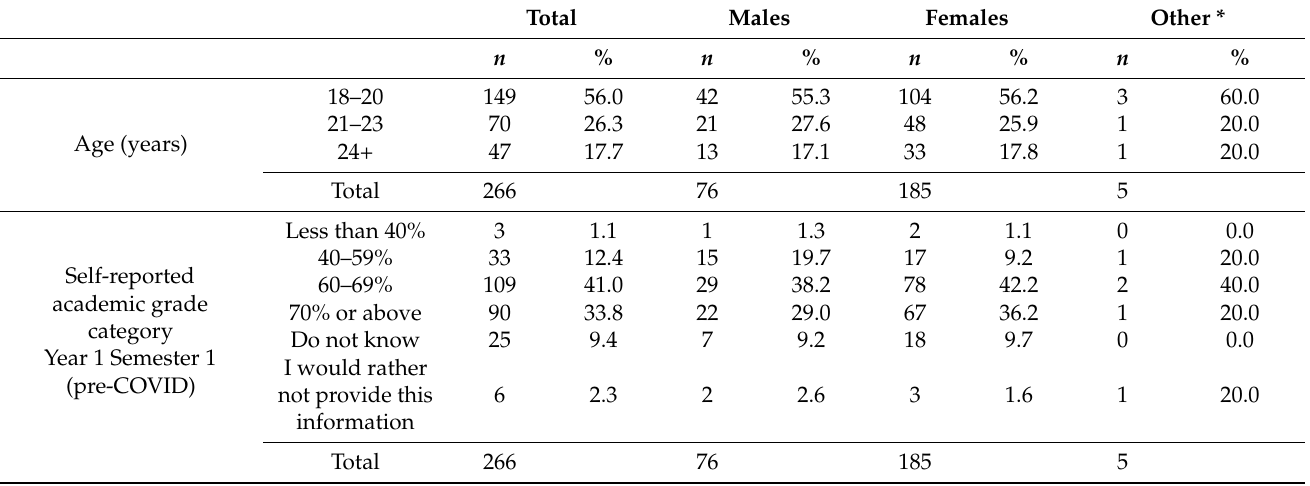
Table 3. Participant demographics by